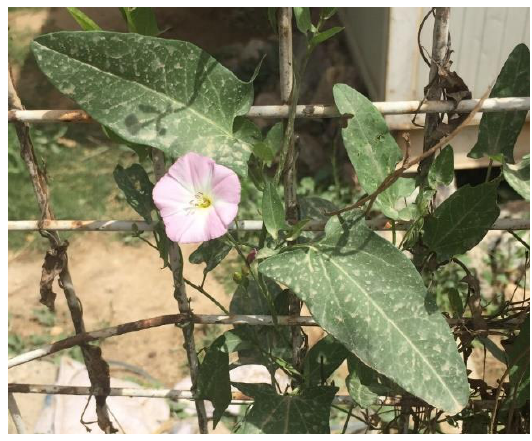
Figure 1. Photo of Convolvulus arvensis Aerial parts of Convolvulus arvensis